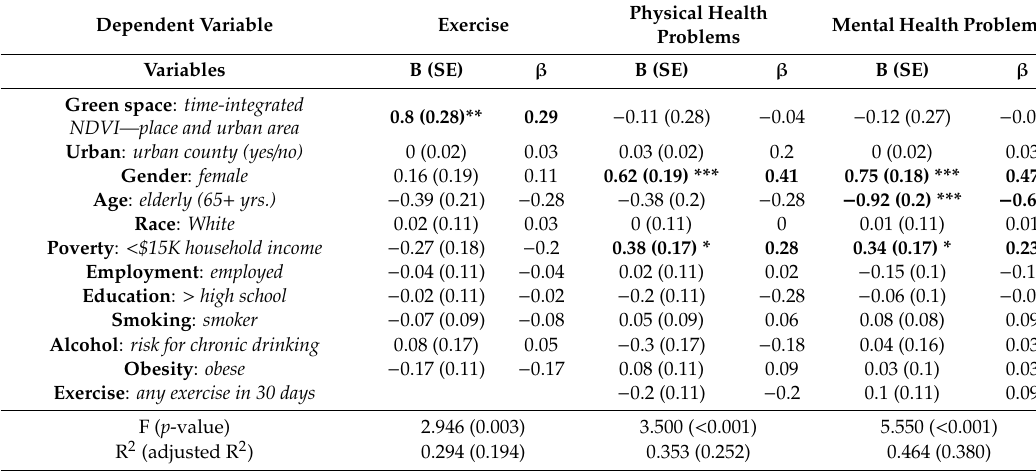
Table 4. Multiple linear regression models to examine the key association between green space, exercise, physical health, and mental health in